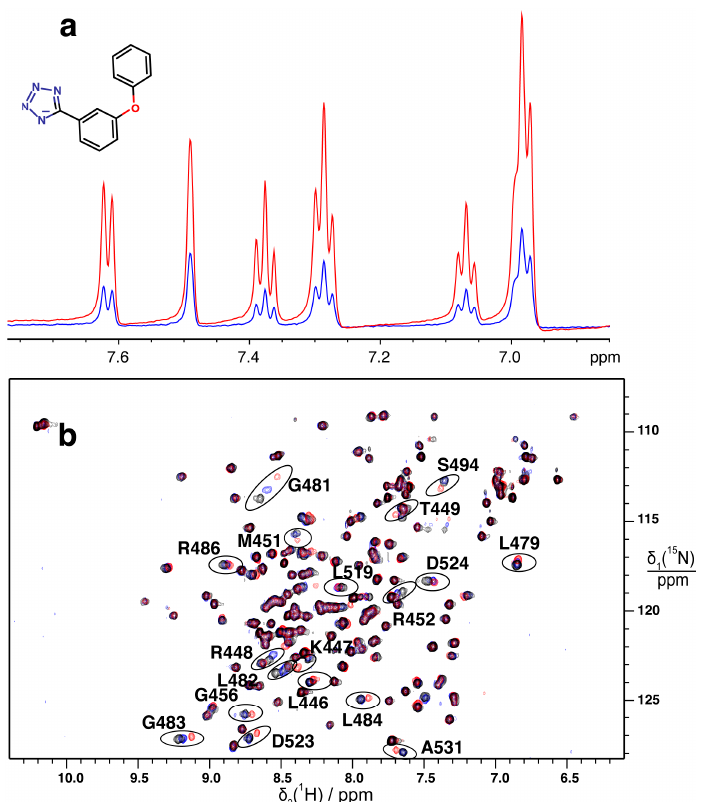
Figure 6. ( a ) Saturation transfer difference (STD) spectrum of compound 6 using DnaG-RCD. In red is a 1D 1 H-NMR reference spectrum, overlaid with a STD spectrum (blue). ( b ) Overlay of 15 N– 1 H HSQC spectra of 15 N-DnaGC (black) with 5 (blue) and 6 (red), each at 1 mM. The apo-protein spectrum is shown in black. Representative assignments of resonances that showed the highest weighted CSP (Figure S3e,f) are shown.